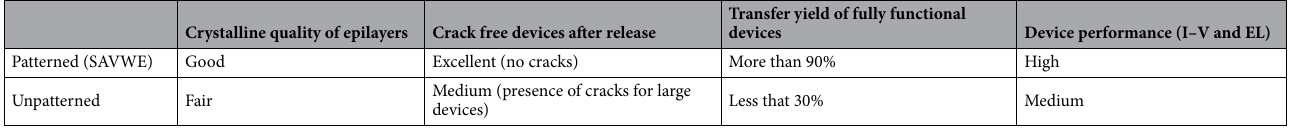
Table 1. Summary of the benefits brought by the use of patterned growth (SAVWE) for the transfer process of devices on host